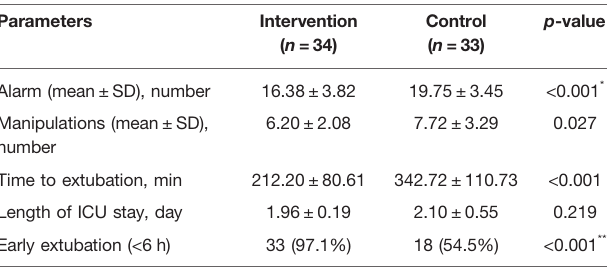
TABLE 5 | Comparison of extubation time and length of ICU stay between the intervention and control groups.